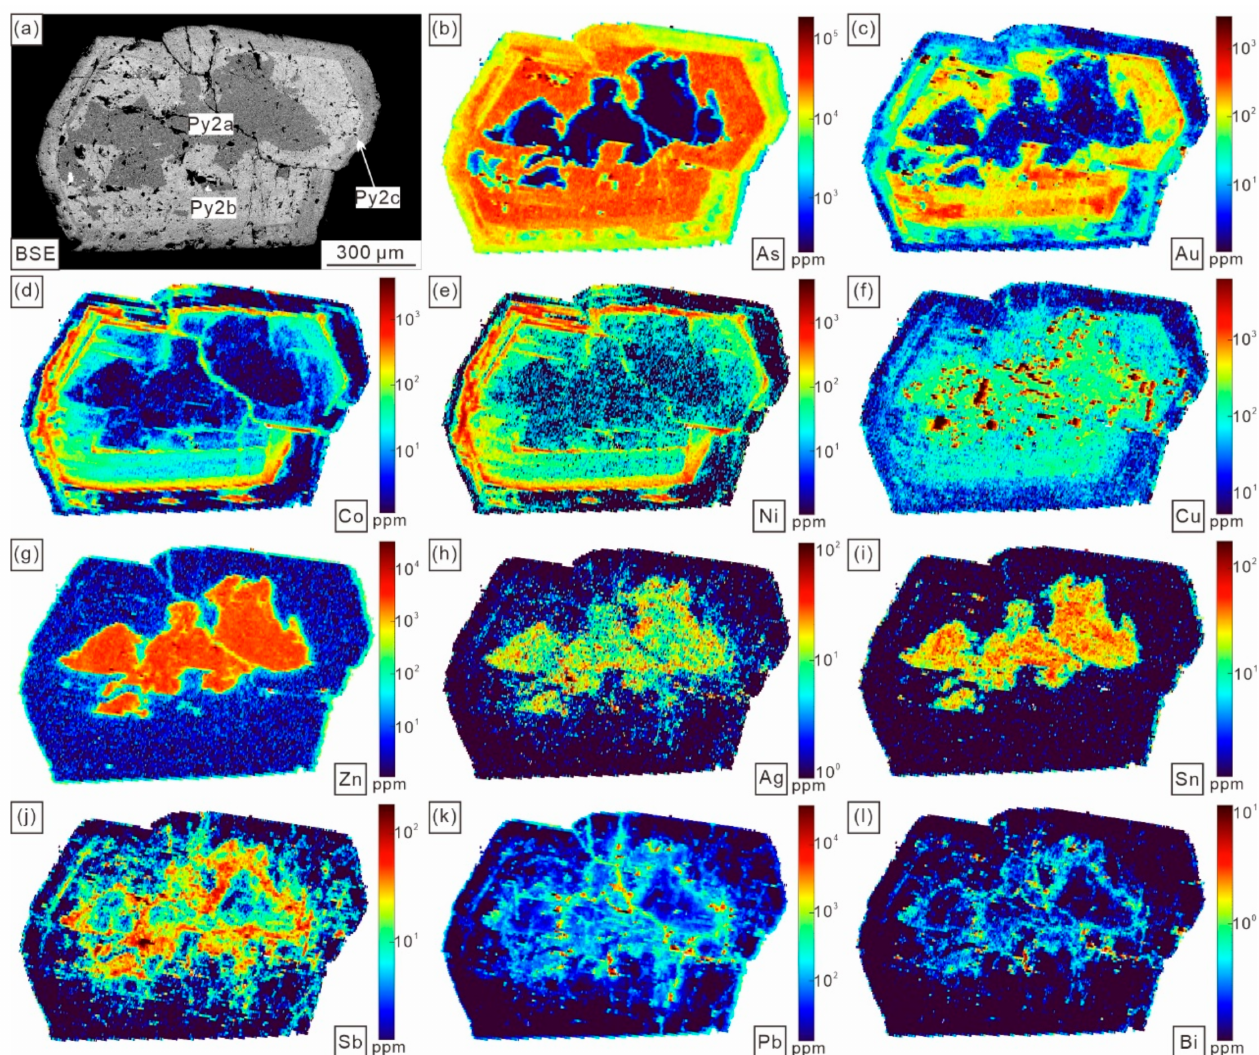
Figure 9. BSE image and coupled LA-ICP-MS trace element mappings of a typical grain of Py2. ( a ) BSE image of a Py2 grain. ( b – l ) Mapping of critical elements in Py2. Py2a is rich in Cu, Zn, Ag, Sn, Sb, Pb, and Bi. Py2b is rich in Au, As, Co, and Ni. Py2c contains a certain amount of Au but is depleted in most trace